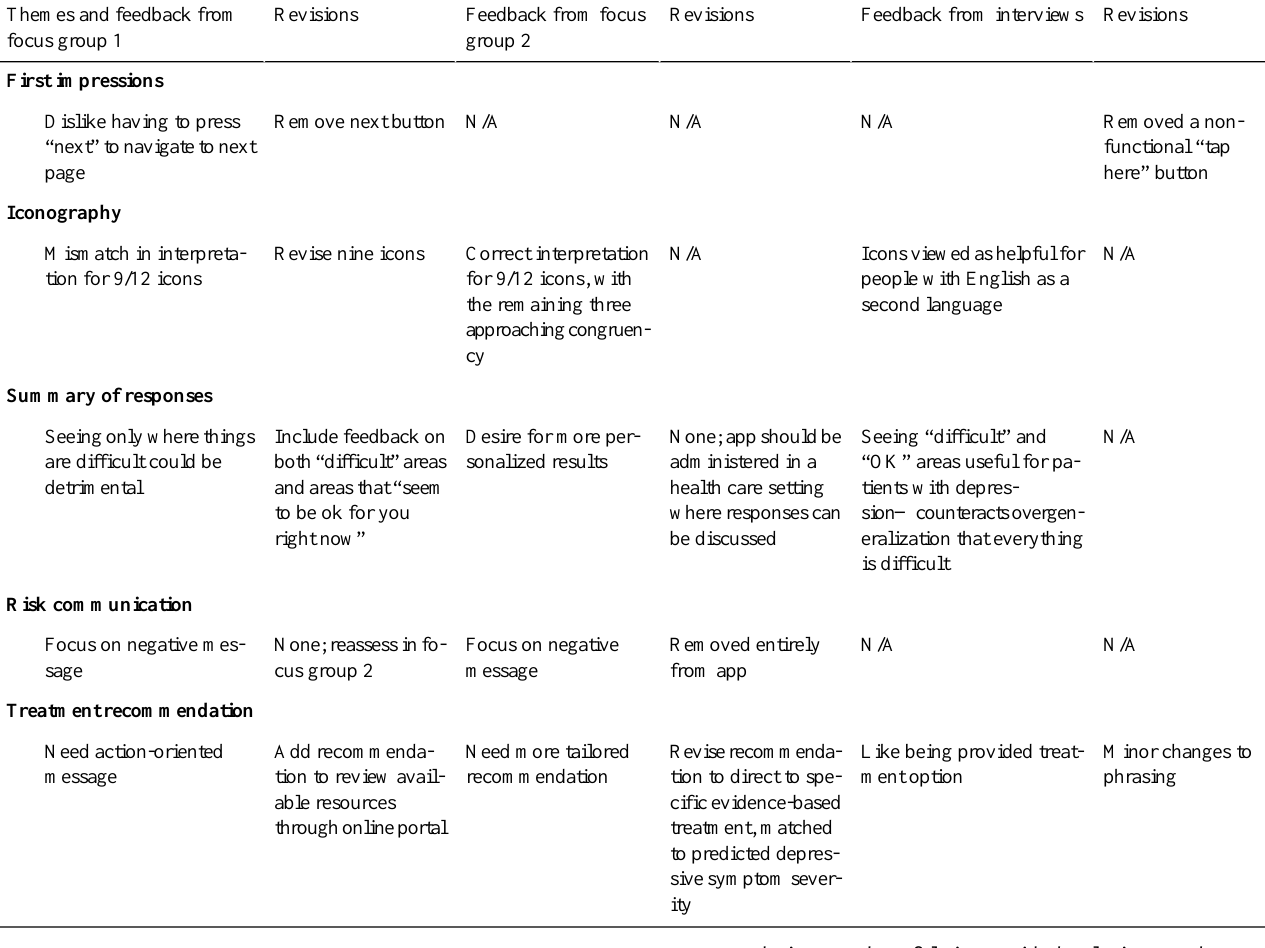
Table 3. Summary of iterative development process (N/A: not applicable).